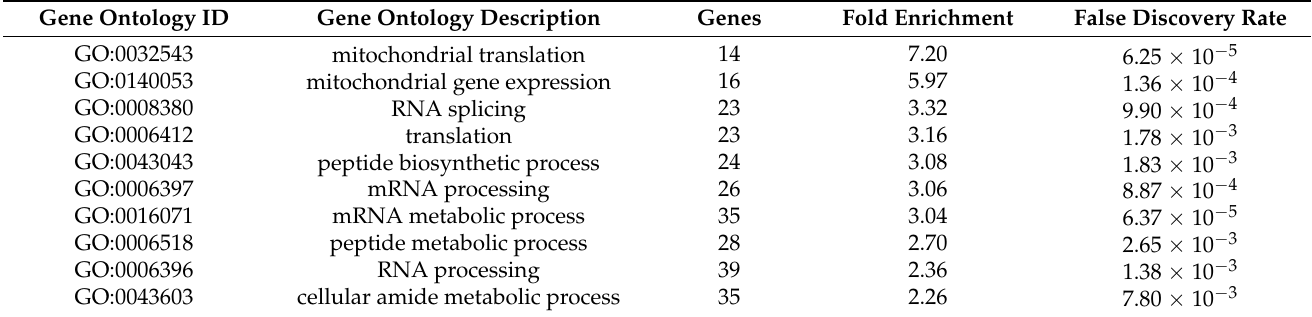
Table 3. Gene ontologies enriched for the DEGs included as selected features.